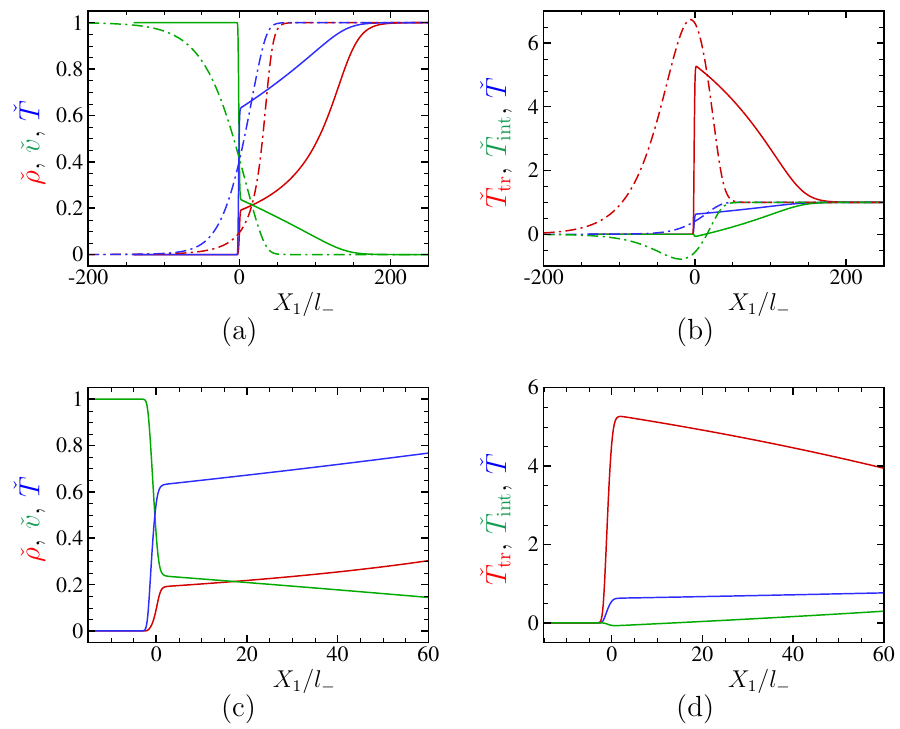
Figure 13. Profiles of ˇ ρ , ˇ v , ˇ T , ˇ T tr , and ˇ T int in the case of SF 6 gas at M − = 5. ( a , c ) ˇ ρ , ˇ v , and ˇ T ; ( b , d ) ˇ T tr , ˇ T int , and ˇ T . Panels ( c , d ) are, respectively, the magnified figures of panels ( a , b ). See the caption of Figure